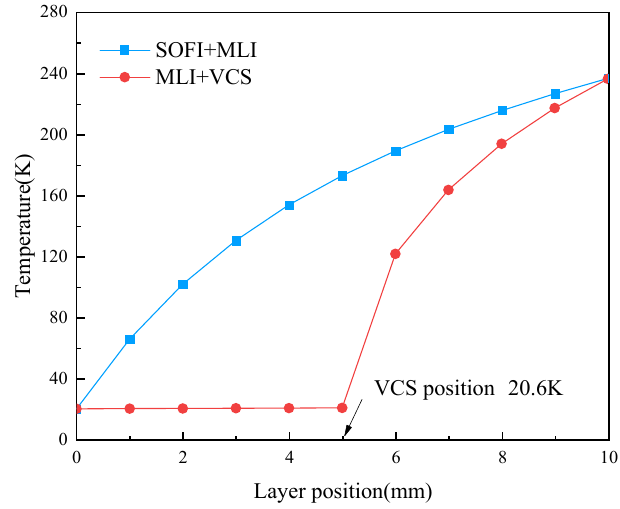
Figure 5. Temperature pro fi le within insulation at thermal equilibrium.